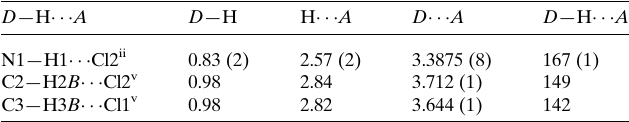
Table 1 Hydrogen-bond geometry (A˚ , (cid:4)